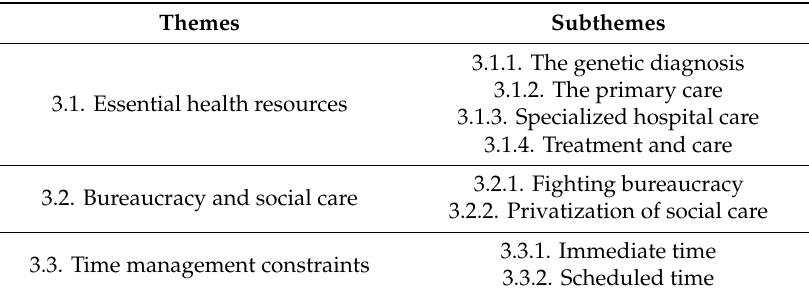
Table 4. Themes that emerged from participant